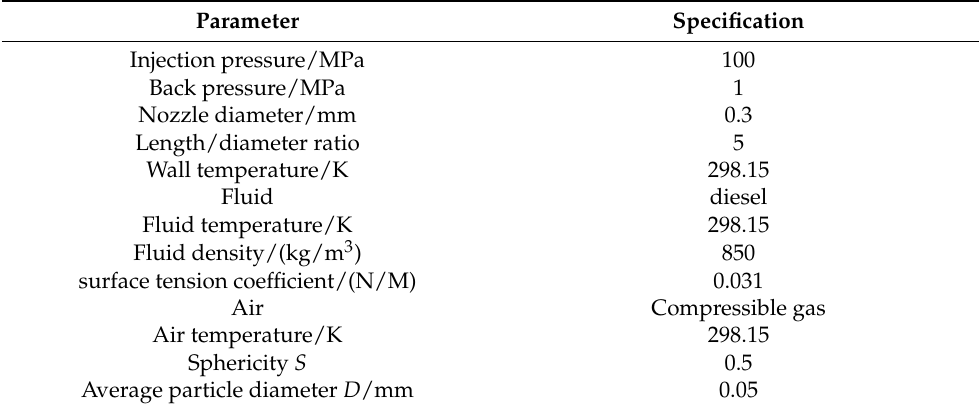
Table 1. Model physical parameters